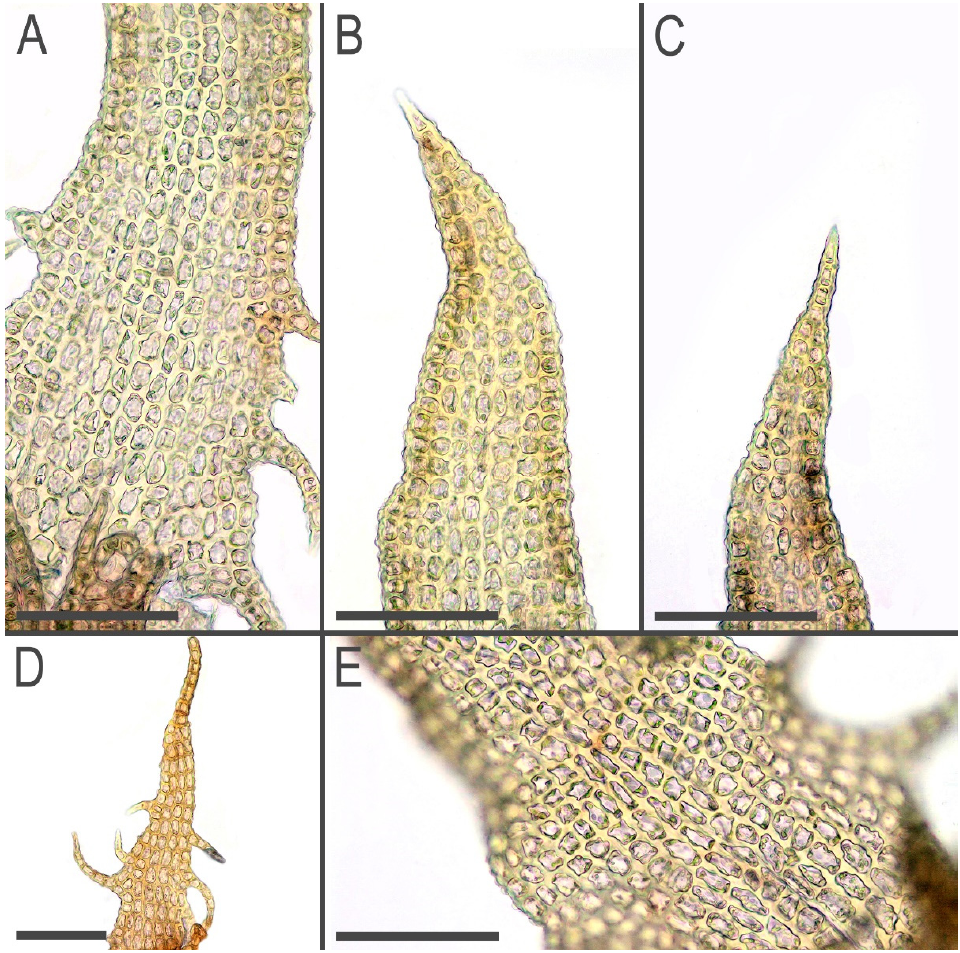
Figure 9. Tetralophozia filiformis (Steph.) Urmi: A , E —leaf lobe bases; B , C —leaf lobe apex cells; D —underleaf lobe apex. Scales: A – E —100 µm. All from C-39-1-17 (VBGI). Comment. The type specimen of the taxon is somewhat smaller than other specimens from Yunnan and Sichuan. It has shorter but the same in width leaves and somewhat wider underleaves (although of the same length as other materials). Moreover, the plants in the lectotype are slightly crumbled, which gives the impression of smaller and shorter plants than commonly in the species. The old, dried herbarium specimens commonly have a less pronounced leaf surface armature, including papillae. The latter may be the consequence of the partial collapsing of the cells and indenting of surface elements inside. The latter is the reason the cuticle elements are not as coarse as in relatively fresh